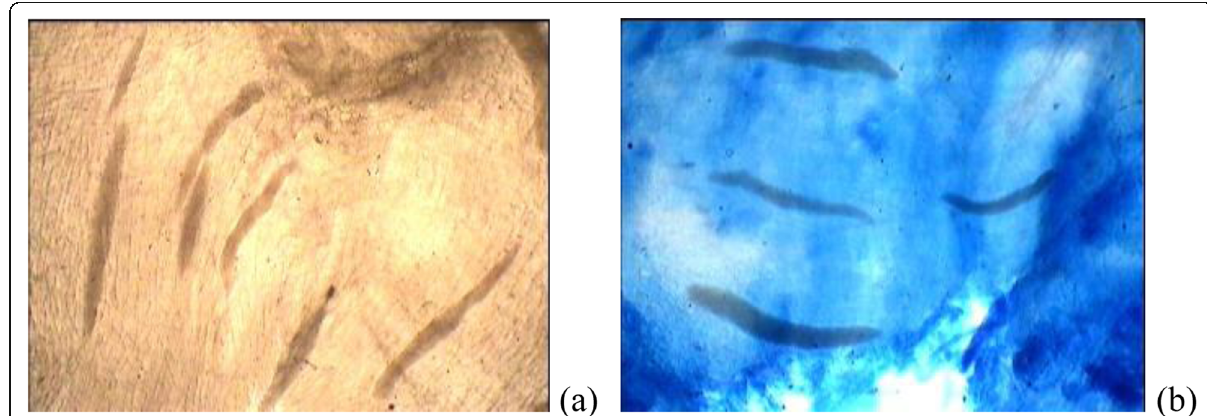
Fig. 1 Muscle squash tissue showing S. hirsuta in the esophagus of cattle. a Unstained. b Methylene